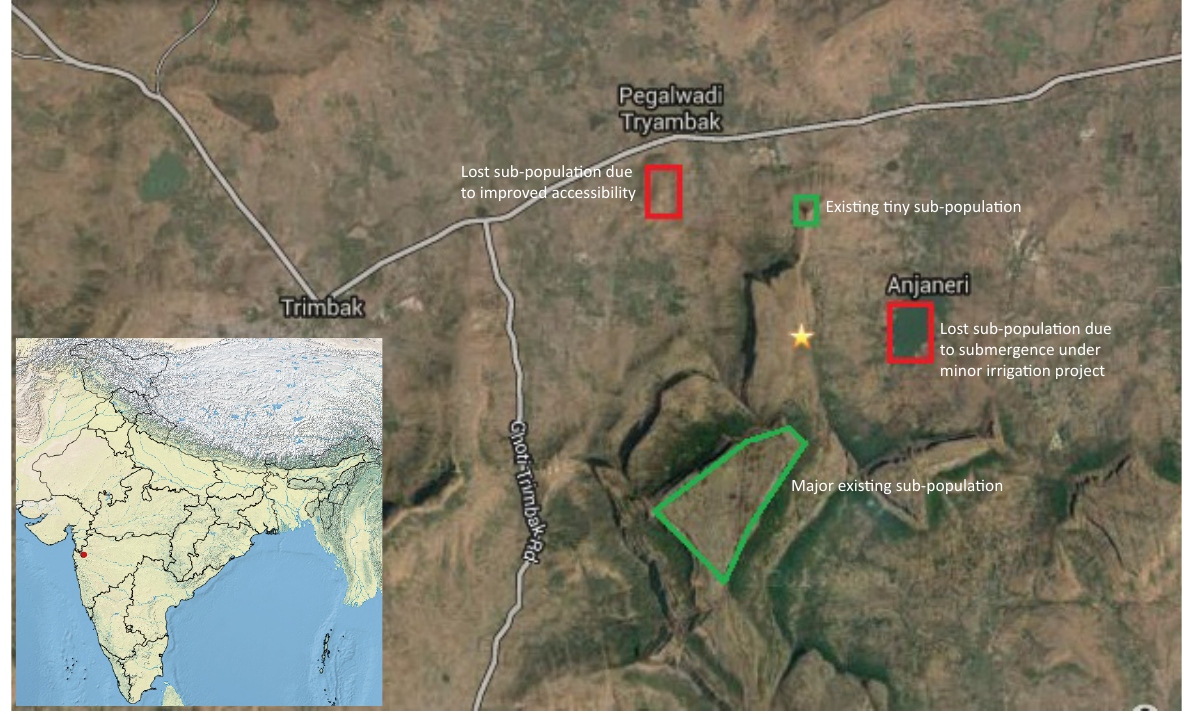
Image 1. Locations of existing sub-populations and extirpated sub-populations of Ceropegia